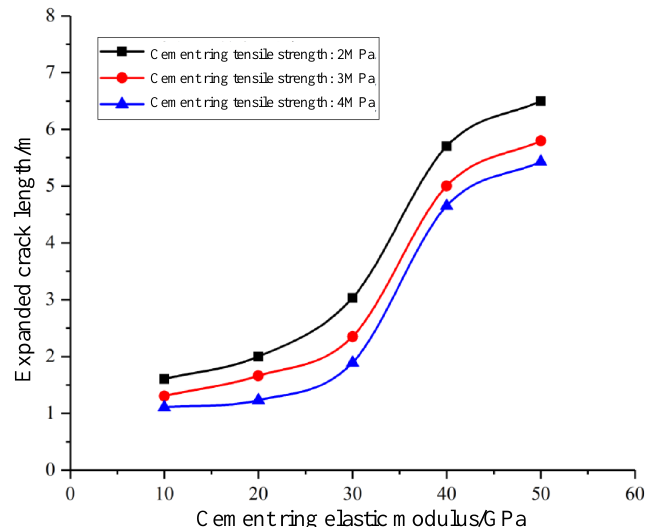
ff ect of mechanical parameters of cement sheath on the crack Figure 17. The effect of mechanical parameters of cement sheath on the crack propagation. Figure 17. The e